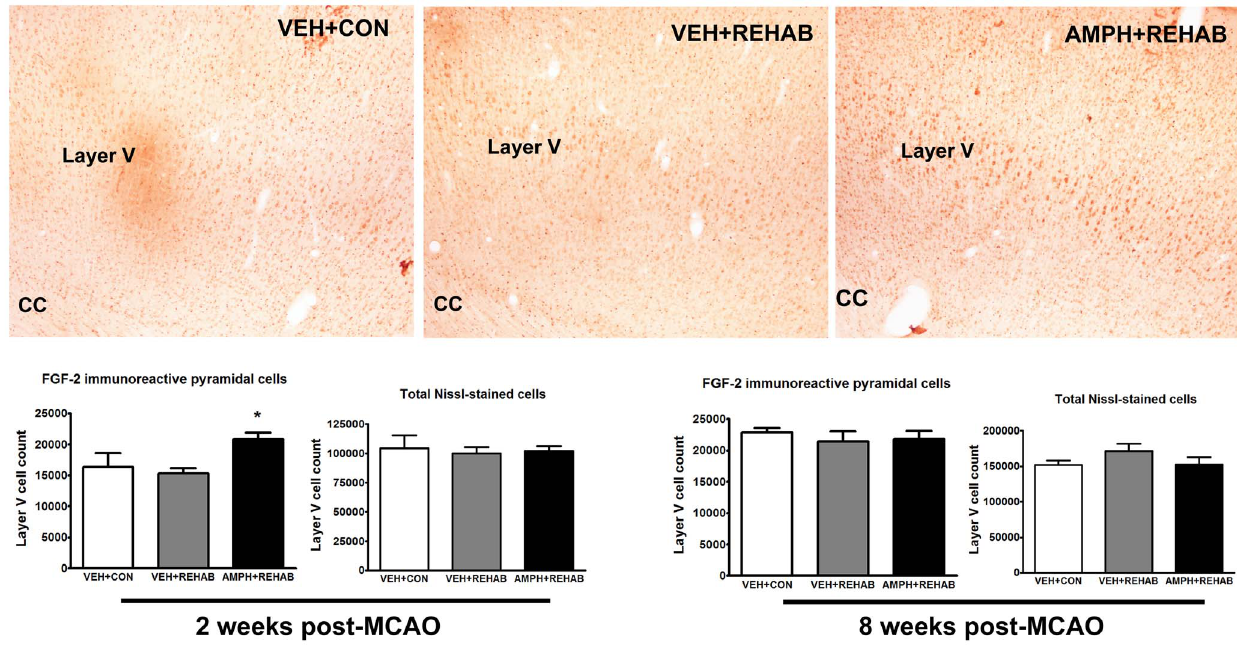
Figure 3. Short term AMPH plus physical rehabilitation increases FGF-2 expression in Layer V pyramidal cells of unlesioned motor cortex. Top panel consists of representative photomicrographs of FGF-2 immunoreactivity in the unlesioned motor cortex. Layer V pyramidal cells are clearly evident and appear more intensely stained in animals receiving AMPH + REHAB as compared to other groups. Left side - Stereological assessment of FGF-2-like immunoreactive layer V pyramidal cells and total Nissl-stained cells in unlesioned motor cortex at 2 weeks after MCAO. Animals underwent behavioral procedures and MCAO as described in Methods and Fig. 1, but were sacrificed 2 weeks post-MCAO for histological procedures. One way ANOVA followed by Student-Newman-Keuls comparisons indicated a significant increase in the number of FGF-2-like immunoreactive pyramidal cells in Layer V as compared to all other groups (p , 0.05). Total number of Nissl stained cells did not differ among groups. Data represent the mean 6 SEM of 6 animals/group. Right side - Stereological assessment of FGF-2-like immunoreactive layer V pyramidal cells and total Nissl-stained cells in unlesioned motor cortex at 8 weeks after MCAO. A subset of animals that contributed to the behavioral data in Fig. 1 were used for assessment of FGF-2 expression. Data represent the mean 6 SEM of 7 animals/group.